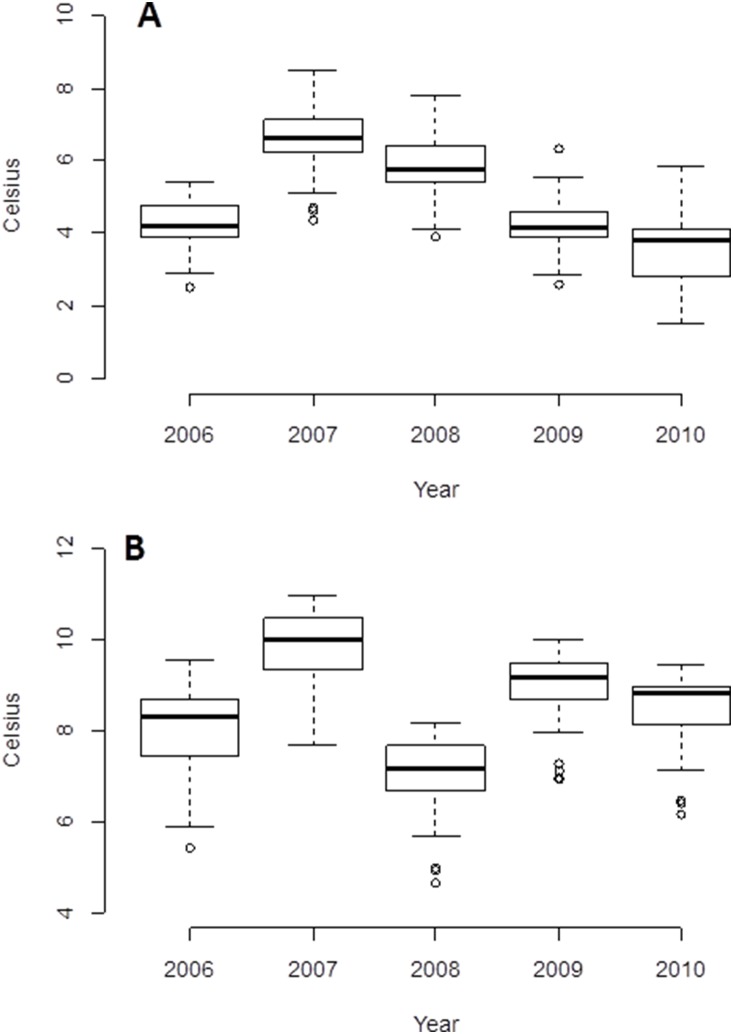
Mean winter (A) and spring (B) temperatures preceding Culicoides activity season across all sites for each year of observation.Box plots show the median (central line), box denotes 25th and 75th percentiles, error bars represent 10th and 90th percentiles, and dots are points outside the 10th and 90th percentiles.